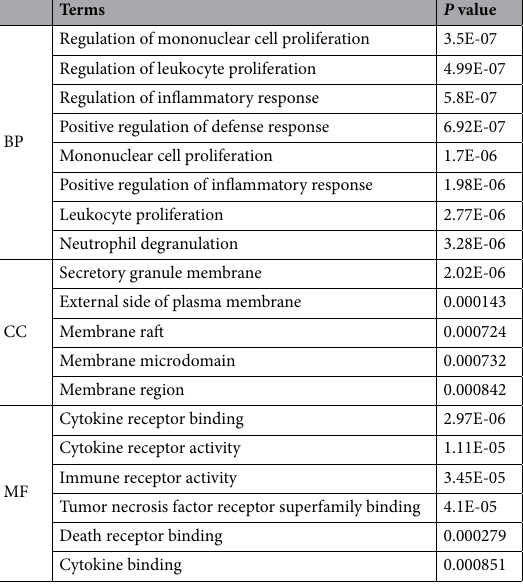
Table 3. GO analysis of co-DEGs.